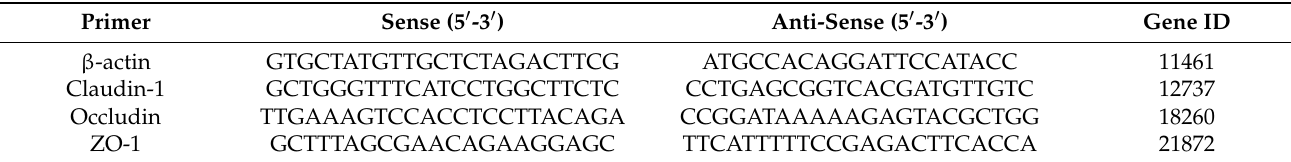
Table 1. Forward and Reverse Primers